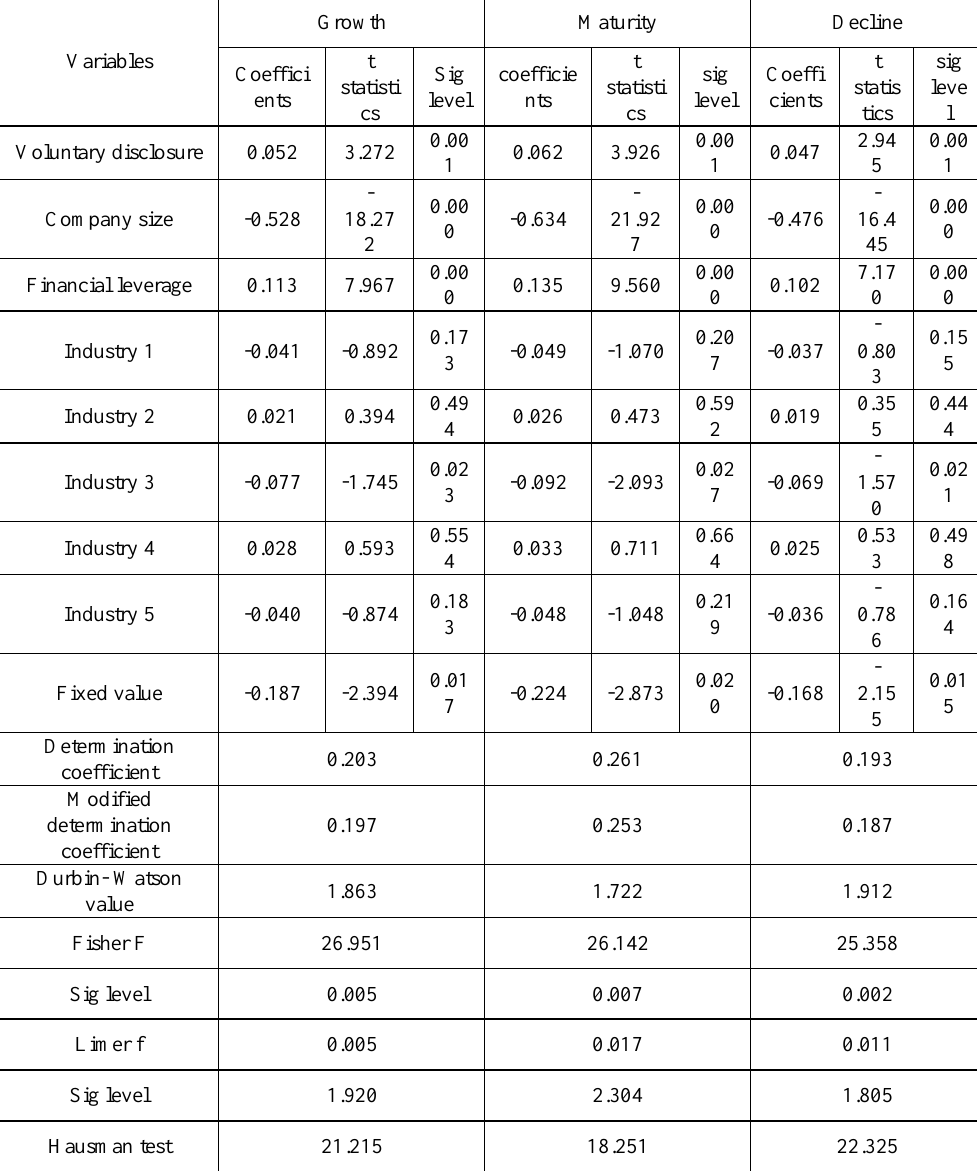
Table 8. Test results for the relationship between voluntary disclosure and refined